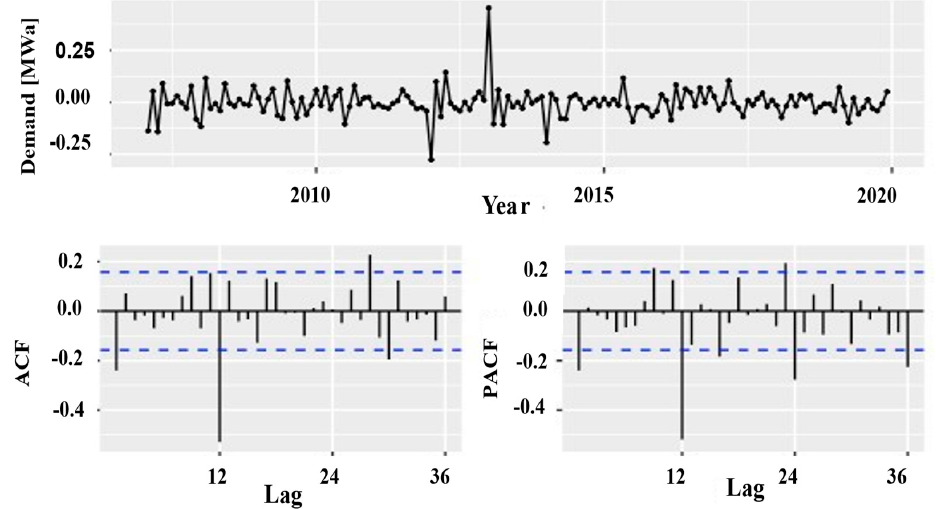
Table 6. Selection of ARIMA model for Zambia’s electricity demand.